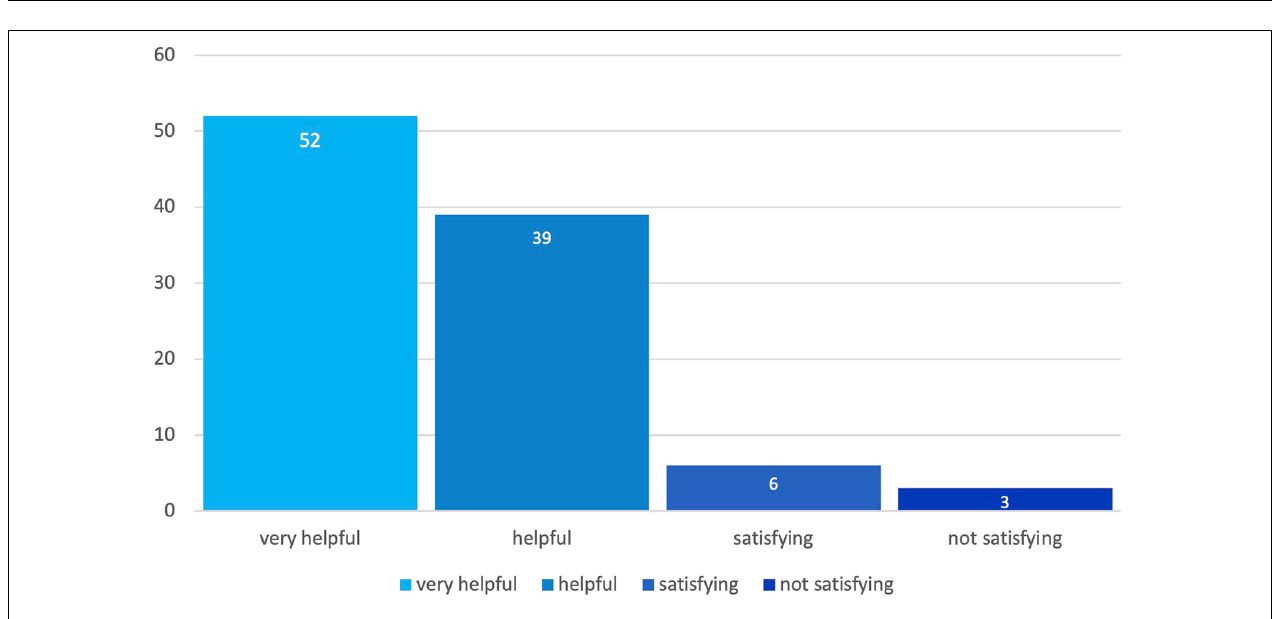
FIGURE 7 | Reflective Functioning Scores of teachers in FA- and ES- group. FA: N = 32; m = 1,84; sd = 1,32. ES: N = 32, m = 3,00; sd = 1,54.